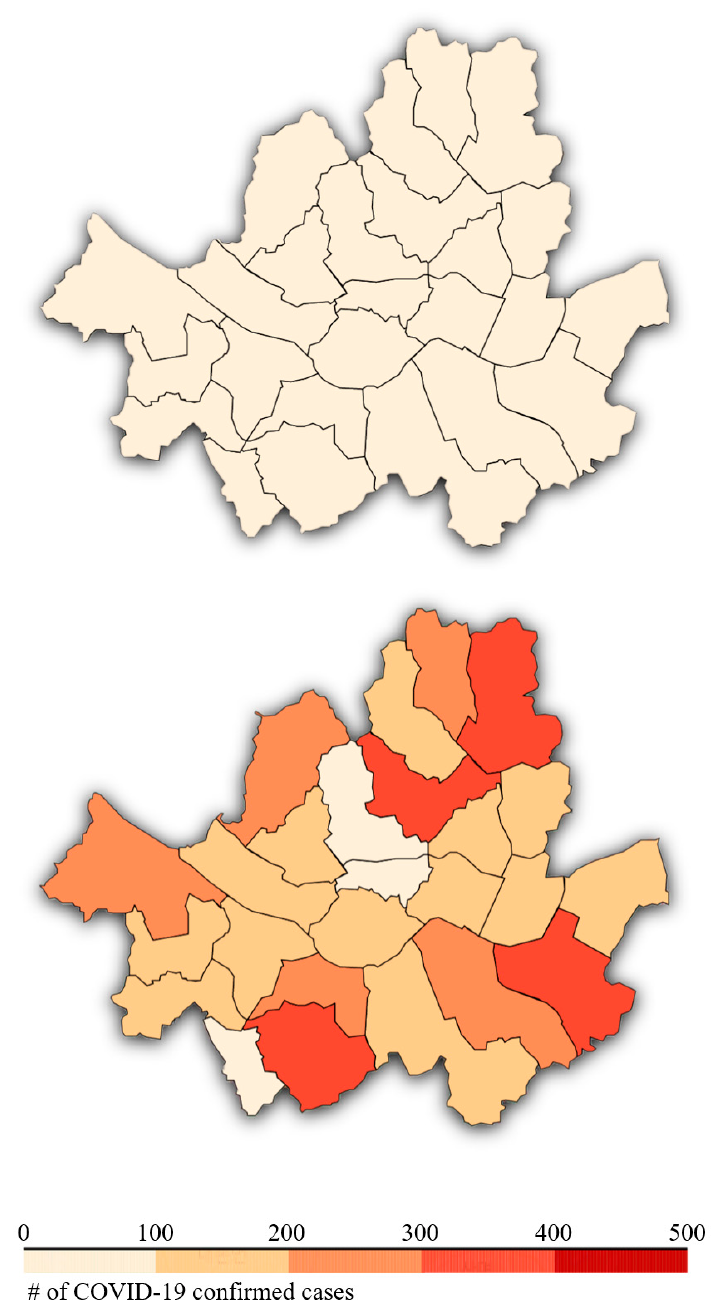
Figure 1. Number of cumulative confirmed cases in Seoul in 2020. The upper and lower figures show the number of infections in February and September, respectively.